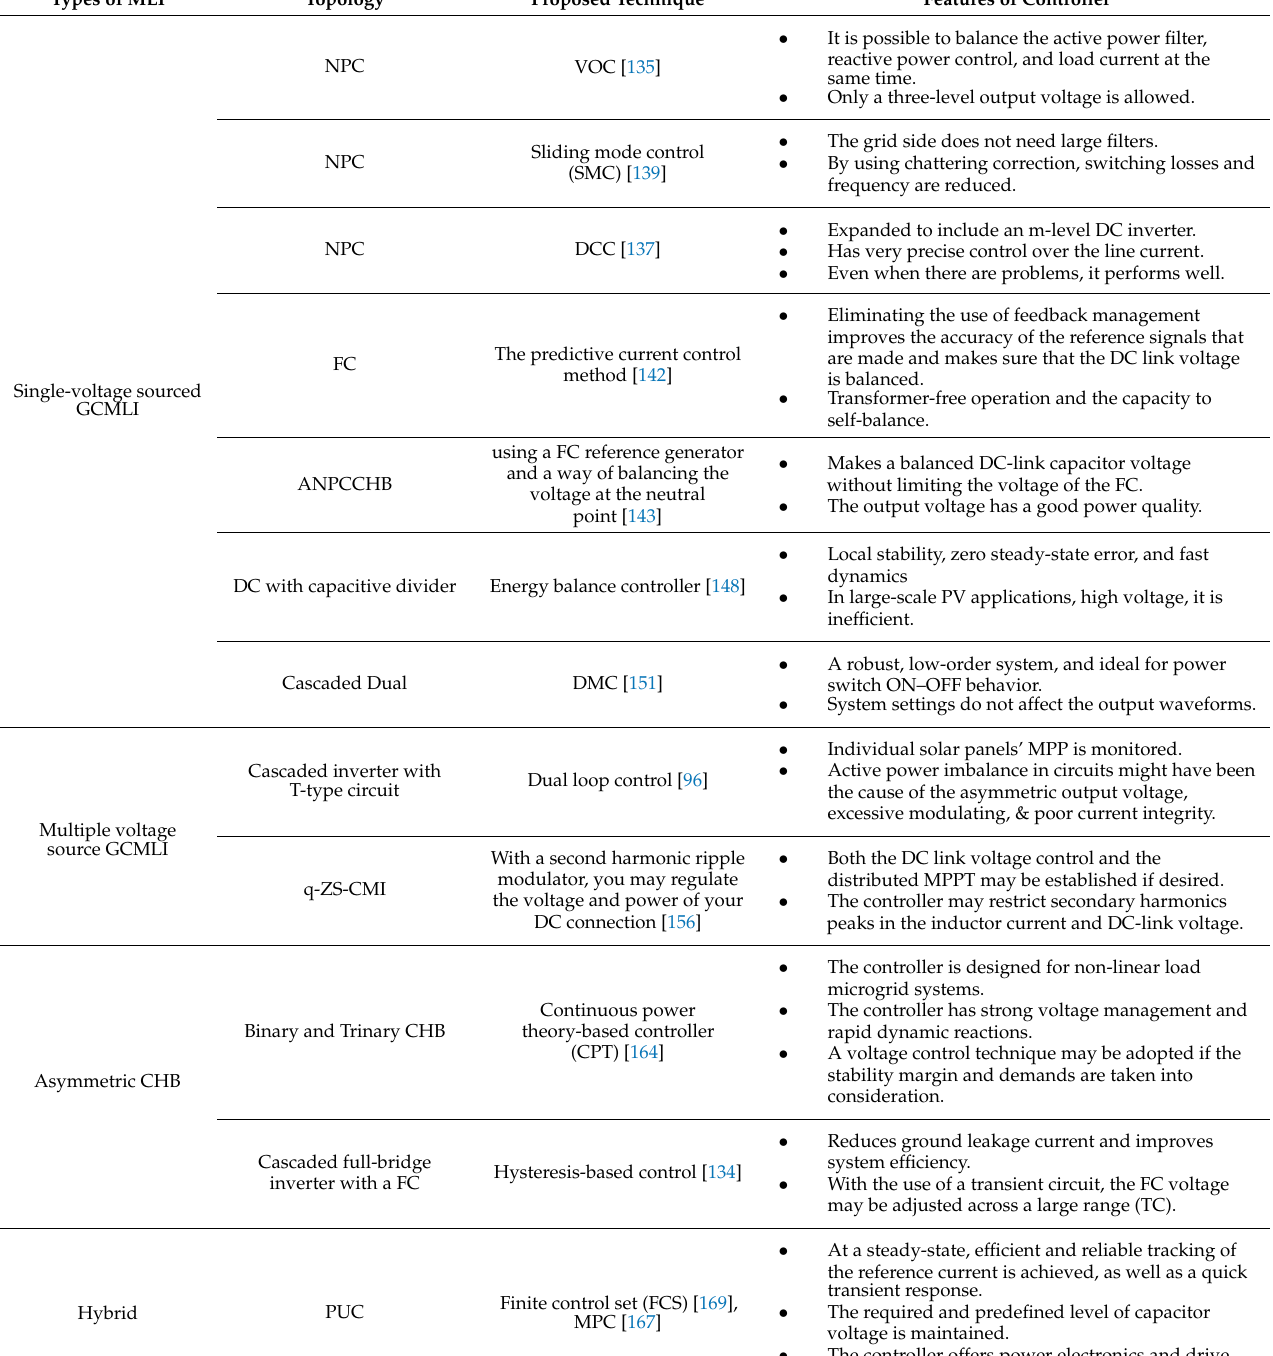
Table 5. Comparative analysis of different controllers used for various GCMLI